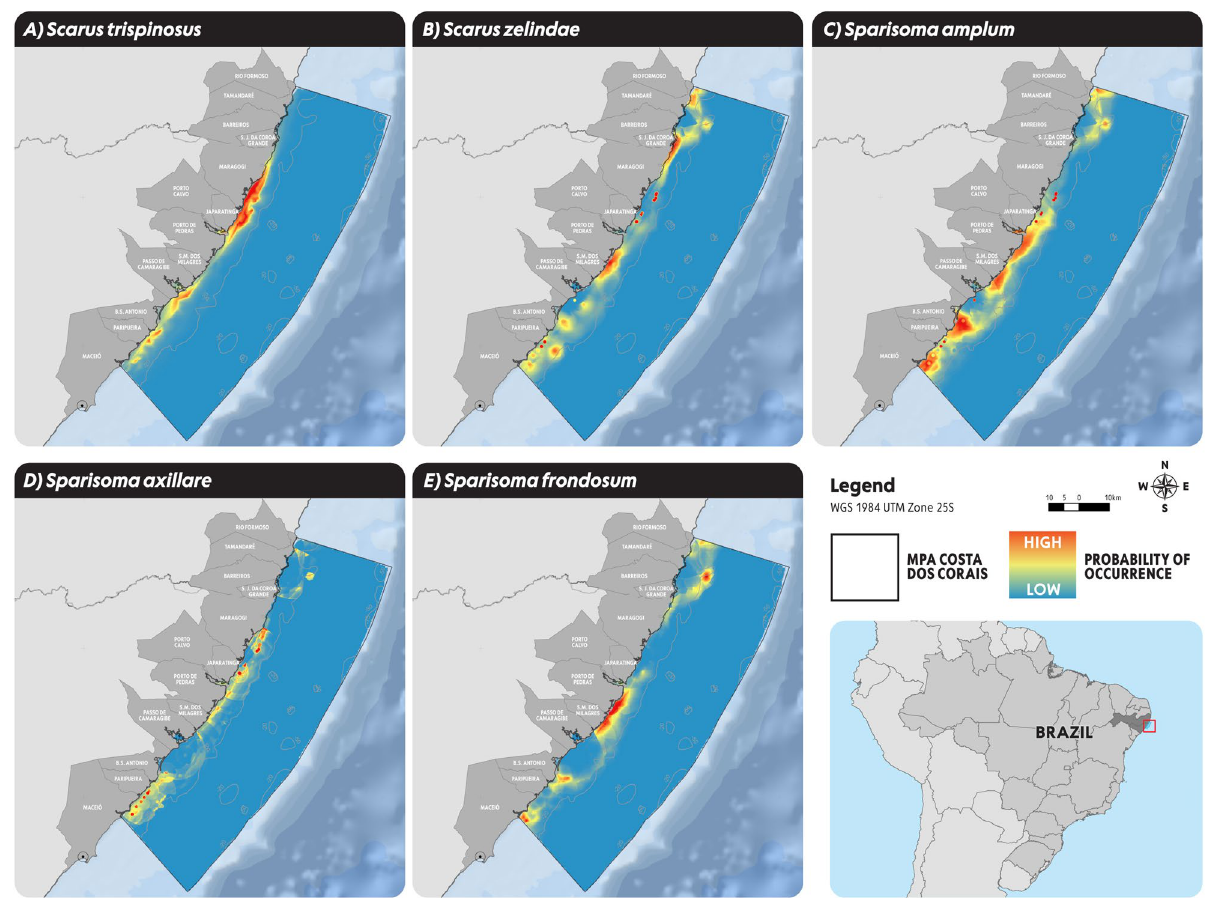
Figure 2. Parrotfish species distribution modelling (SDM) whitin MPA Costa dos Corais for imperiled parrotfish species: ( A ) Scarus trispinosus ; ( B ) Scarus zelindae ; ( C ): Sparisoma amplum ; ( D ) Sparisoma axillare ; ( E ) Sparisoma frondosum . Figure elaborated by the authors using Arcgis